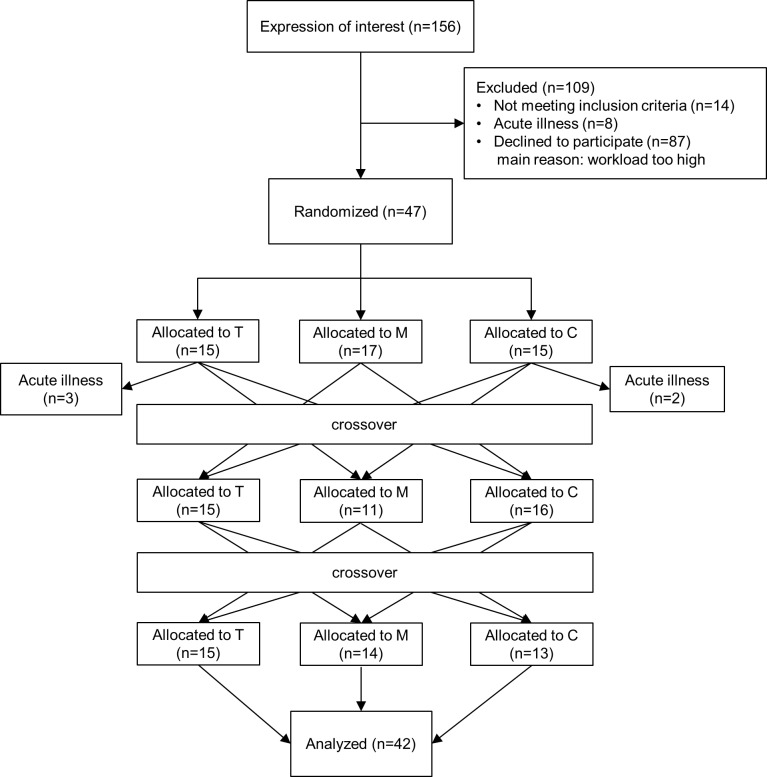
Participant flow diagram.M: outdoor mountain hiking, T: indoor treadmill walking, C: sedentary control condition.